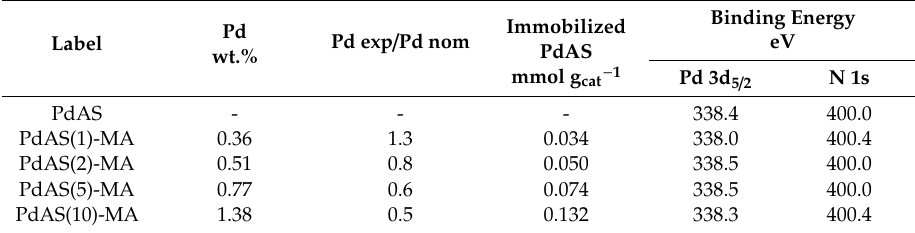
Table 2. Pd wt.% by inductively coupled plasma optical emission spectrometry (ICP-OES), Pd experimental / Pd nominal ratio, immobilized PdAS and X-ray photoelectron spectroscopy (XPS) core level of Pd 3d 5 / 2 and N1s for PdAS(x)-MA polymers.